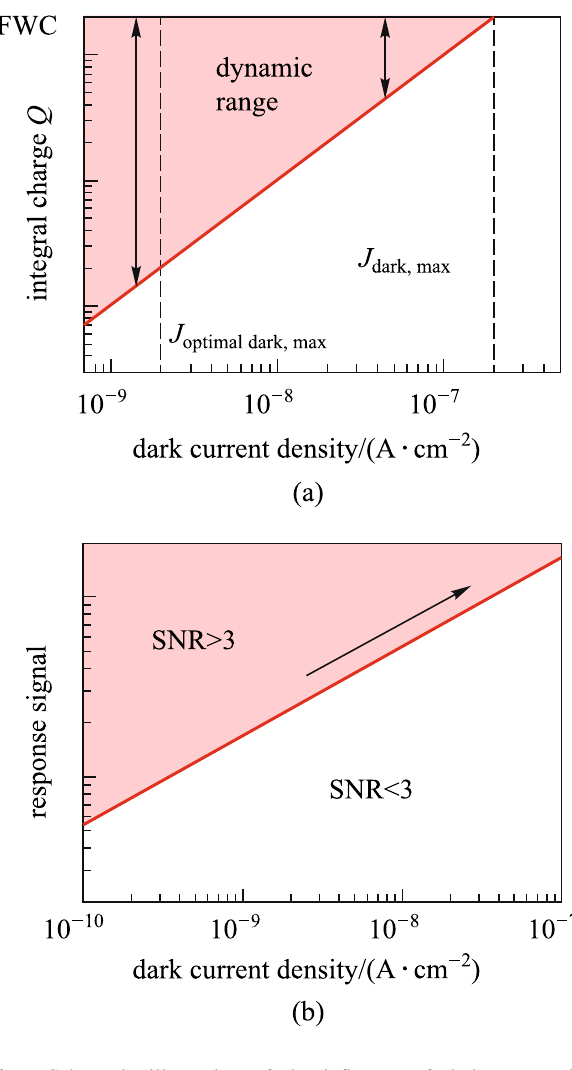
Fig. 1 Schematic illustration of the influence of dark current in FPXIs. a Integral charge ( Q ) against the dark current density J dark . When J dark flushes the collection capacitor to FWC within t , the dynamic range diminishes to 0. b Minimum detectable signal ( J signal, min ) against the dark current density ( J dark ). J signal, min is the response signal of the minimum detection dose, corresponding to a minimum detectable signal-to-noise ratio (SNR) of 3